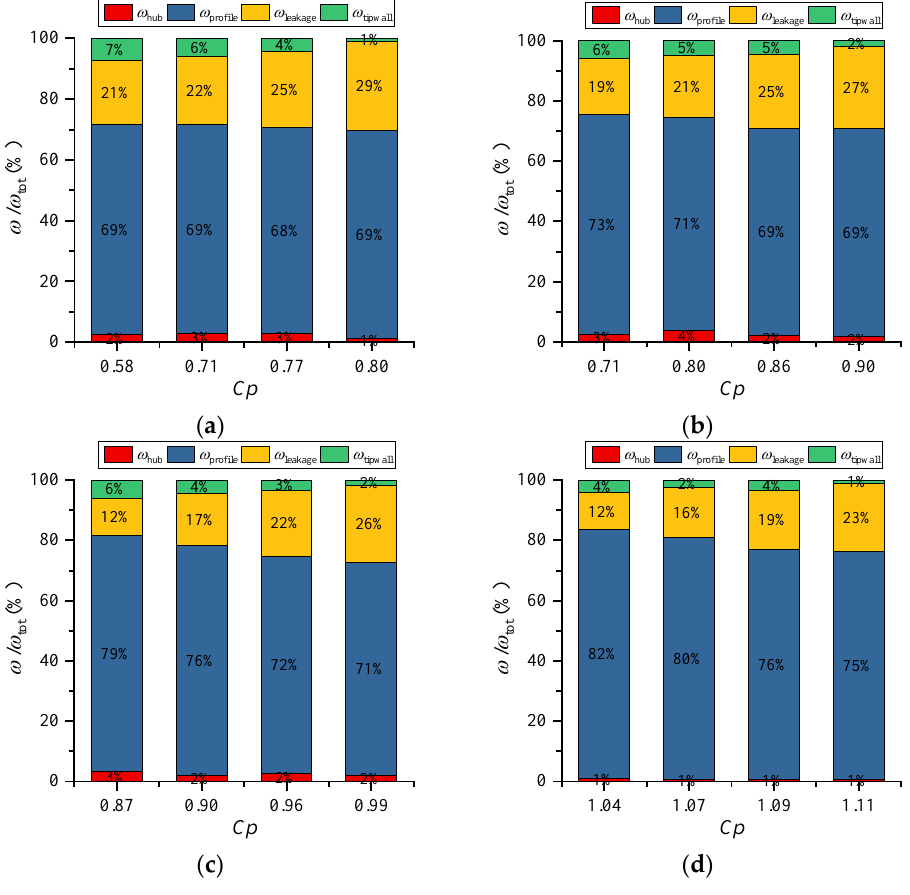
Figure 22. The composition of loss for the rotor blade: ( a ) ψ = 0.41; ( b ) ψ = 0.47; ( c ) ψ = 0.55; ( d ) ψ = 0.65.